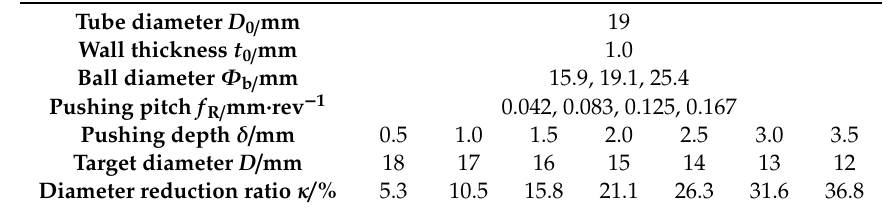
Figure 12. Schematic diagram of processing. Table 2. Conditions of experiment.